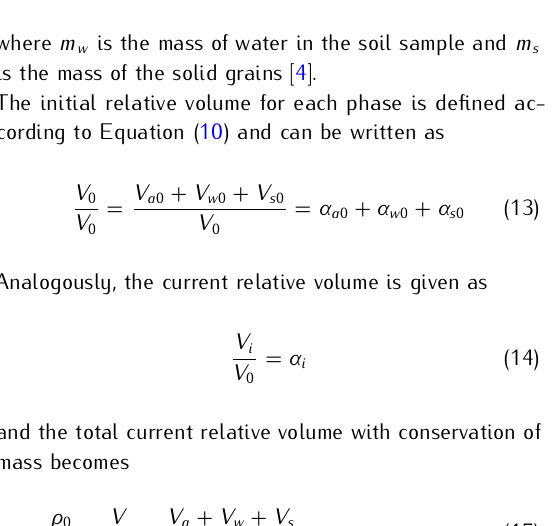
If the degree of saturation is 1 ( i.e. 100%), the soil is